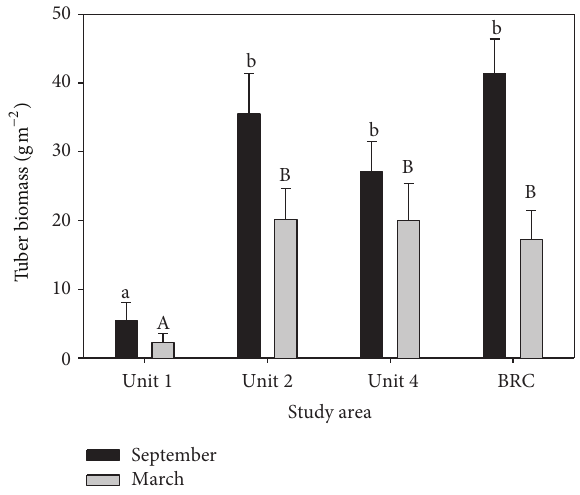
Figure 1: Tuber biomass in sediments of the four study wetlands in September(beforeswansstartedforaging)andinMarch(afterswans stopped foraging to migrate to breeding grounds). Multiple Analysis of Variance tested for differences among wetlands and dates. Same letters indicate no significant differences among wetlands. Capitalization emphasizes which observations are compared. Error bars =